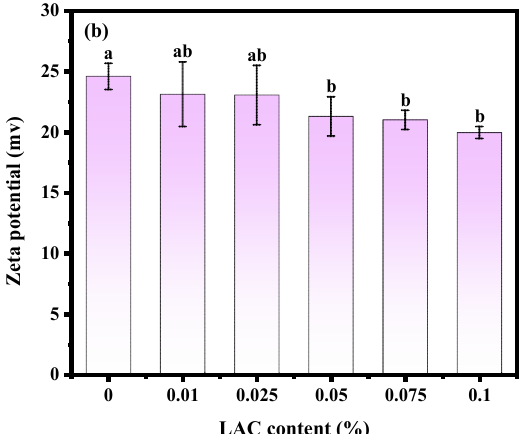
Figure 4. Effect of LAG on particle size distribution ( a ) and zeta potential ( b ) of soy yogurt. Different letters indicate that the values are significantly different ( p < 0.05).